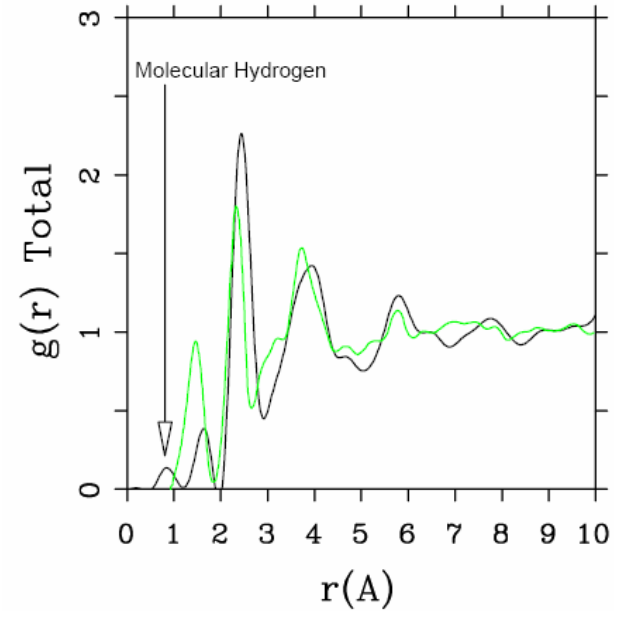
Figure 4. Total RDF for the 10/2 fs cell of a -SiH (black line) that shows the presence of molecular hydrogen, compared to the experimental results (green